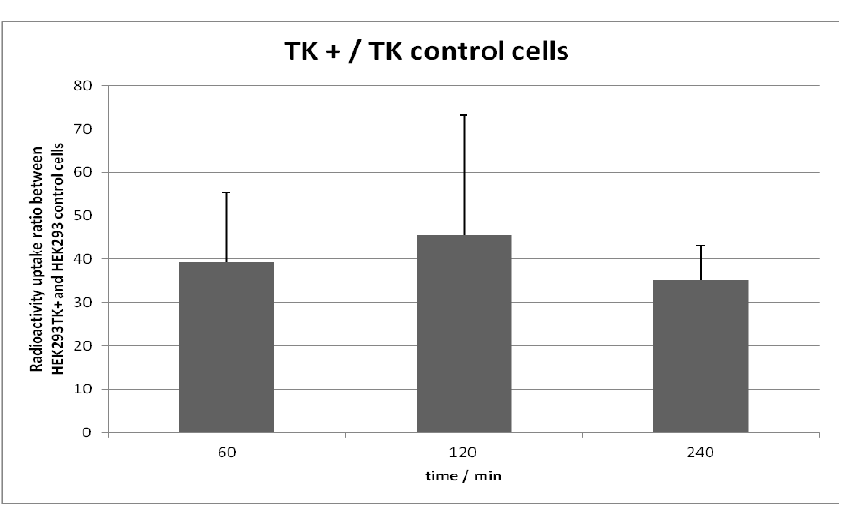
Figure 2. Uptake ratios of HHB-5-[ 18 F]FEP in HEK293TK+ and wild type cells.